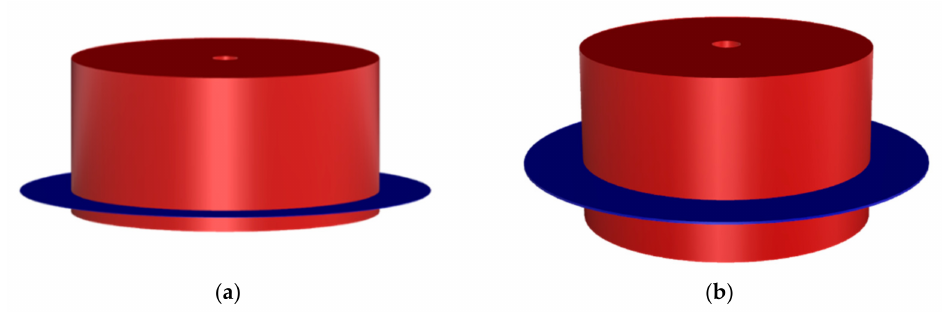
Figure 2. Mooring buoy hull options: ( a ) option A; ( b ) option